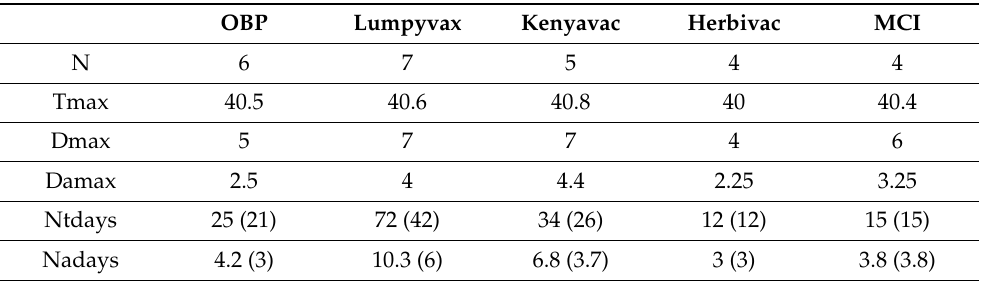
Table 3. The summarized fever response after vaccination (dpv) in the vaccinated groups. N: number of animals with elevated body temperatures; Tmax: highest body temperature measured (in ◦ C) in the group; Dmax: longest period of elevated body temperatures (in days) in the group; Damax: averaged longest consecutive period with elevated body temperatures (in days); Ntdays: total of days with elevated body temperatures; Nadays: average number of elevated body temperatures (in days); between brackets: the number of days with body temperature higher than 39.4 ◦